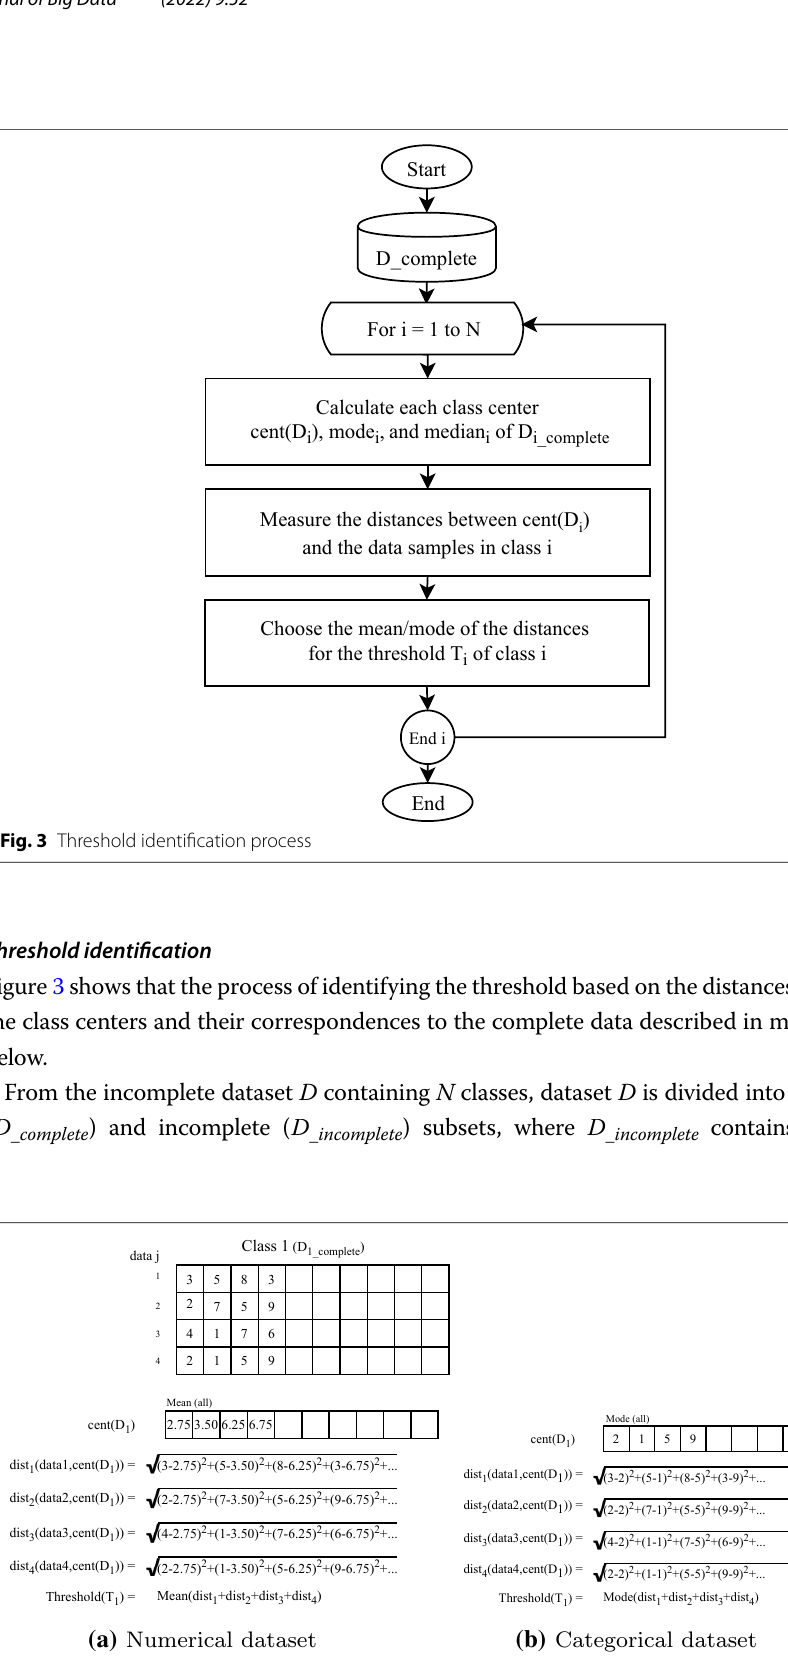
Fig. 4 Examples of the class center and distance calculations for Class 1 in ( a ) a numerical dataset and ( b ) a categorical